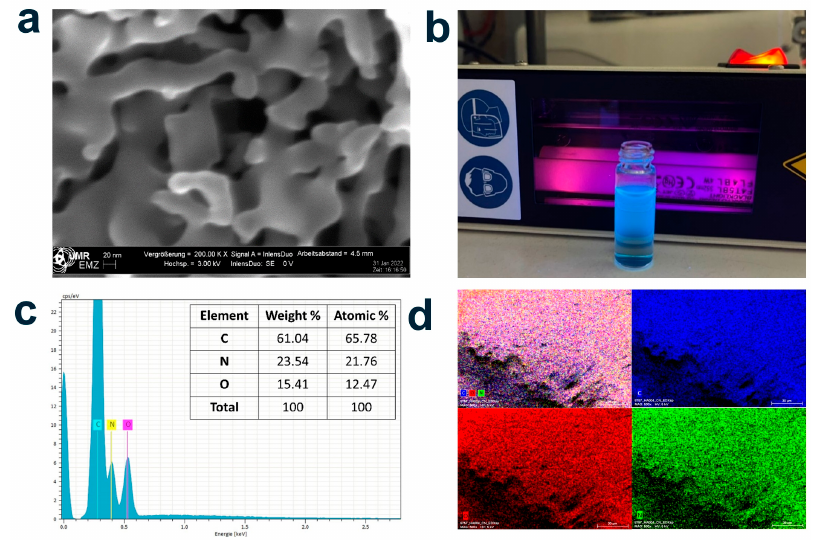
Figure 2. SEM image ( a ), Tyndall effect ( b ), EDX analysis ( c ), and EDX mapping for carbon C, N, and O of NCQDs ( d ).